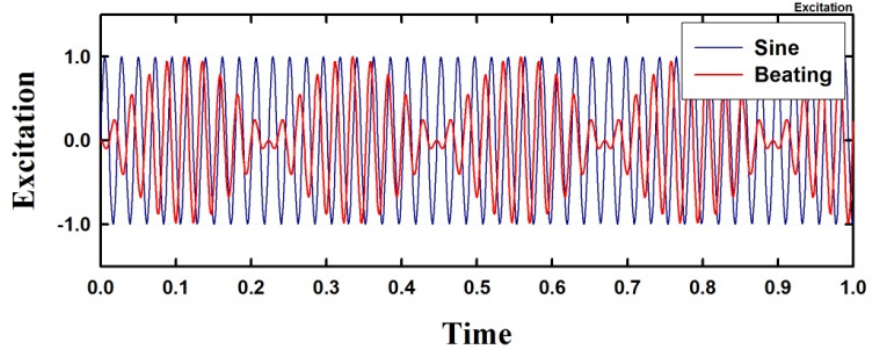
Figure 6. Sinusoidal and beating excitations excitation ( α (cid:3404) 1.0, β (cid:3404) 0.1 ).